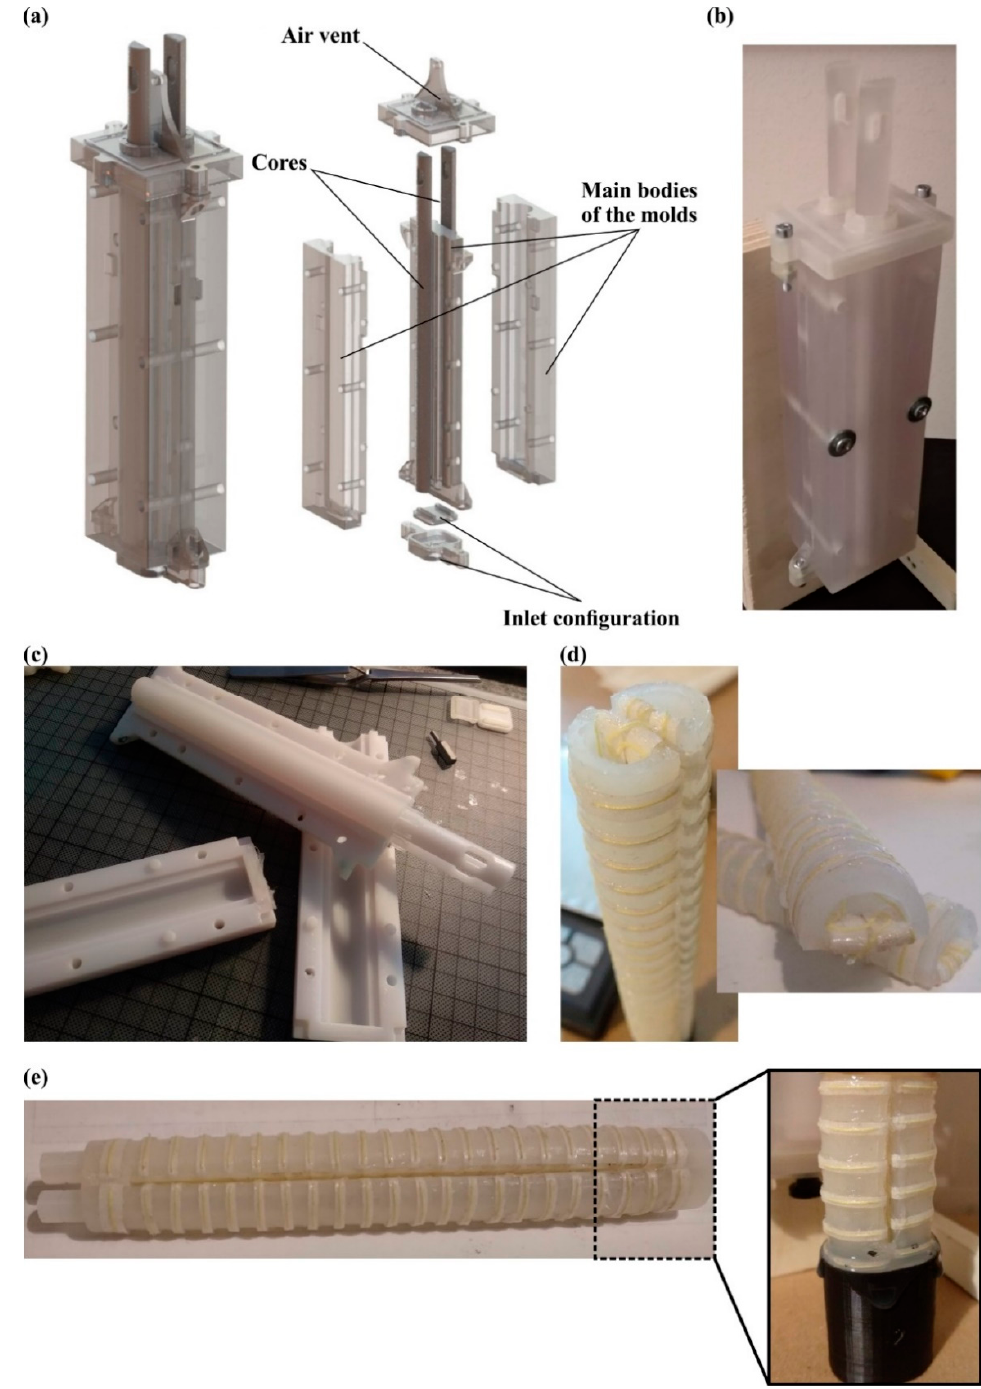
Figure 3. ( a ) A 3D model and exploded view of the silicone molds; ( b ) Image of the 3D printed mold; ( c ) Releasing process of the pneumatic chamber from the molds; ( d ) Indicative Kevlar reinforcement of the pneumatic chambers; ( e ) Bonding and final design of the soft actuator.